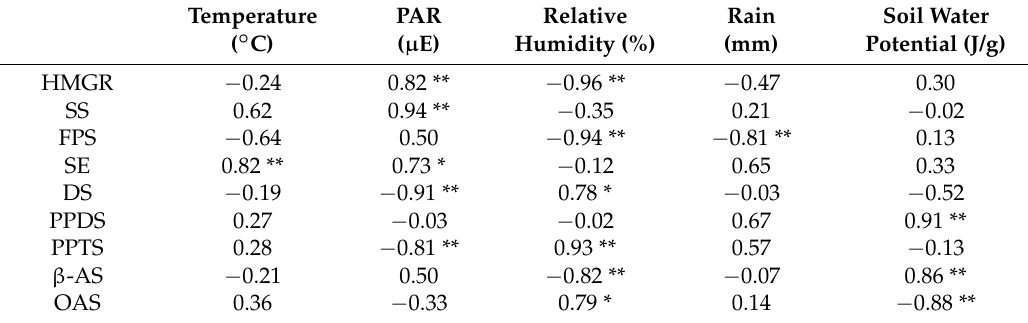
Table 9. Correlation analysis between environmental factors and gene expression in roots at different growth